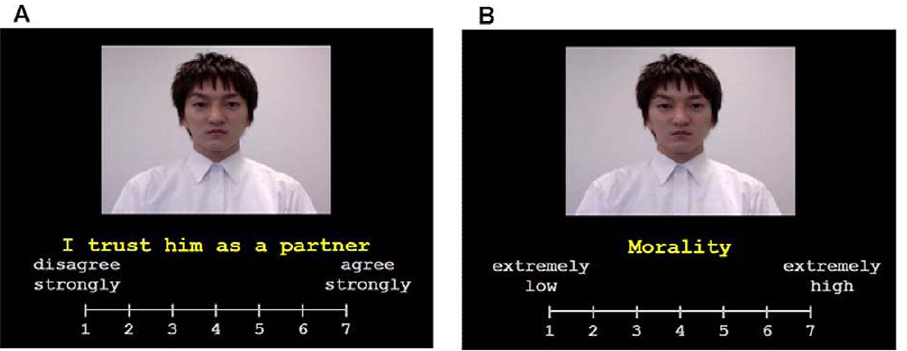
Figure 2. Experimental design of trust game. A trial in the game was divided into a decision phase and an outcome phase and was played with moving image partners. During the decision phase, the chosen option by participants was required within 2.5 s after the start of the trial. The parson depicted in the photograph has given written informed consent, as outlined in the PLoS consent form, to publication of his photograph.